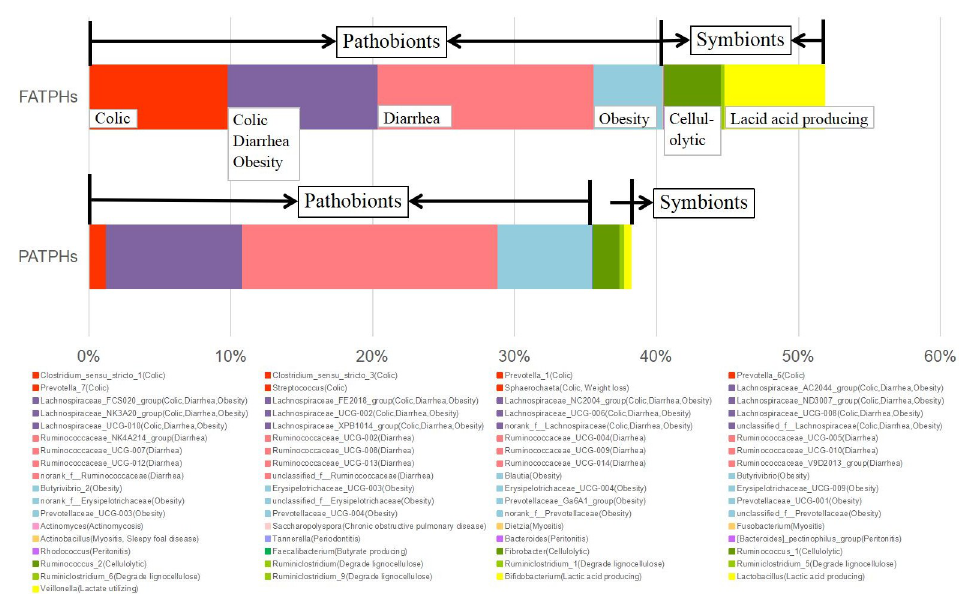
Fig 5. Relative abundances of pathobionts and symbionts at genus level in the FATPHs and PATPHs.